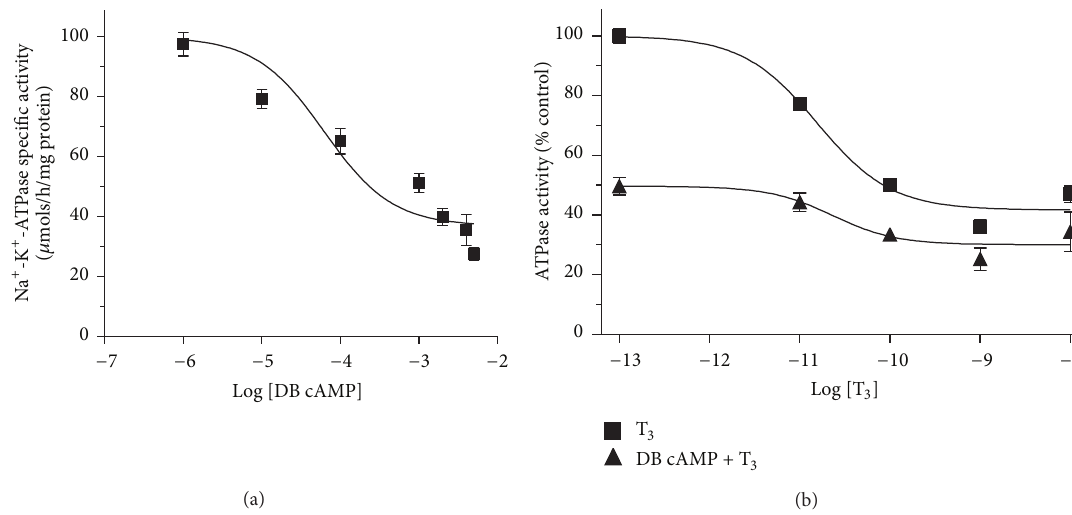
Figure 7: Influence of DB cAMP and T 3 on synaptosomal Na + -K + -ATPase activity, in vitro . (a) Inhibitory effect of various doses of DB cAMP on synaptosomal Na + -K + -ATPase activity, in vitro . The data are represented as mean ± SEM of four separate experiments, taking six animals in each group. The vertical bars denote SEM. (b) Interaction of the effects of of DB cAMP and T 3 on synaptosomal Na + -K + -ATPase activity, in vitro . Filled squares indicate effects of graded doses of T 3 (0.001 nM–10nM) alone on Na + -K + -ATPase activity while filled triangles indicate effects of the 0.2 mM dose of DB cAMP with graded doses of T 3 (0.1 pM–1 𝜇